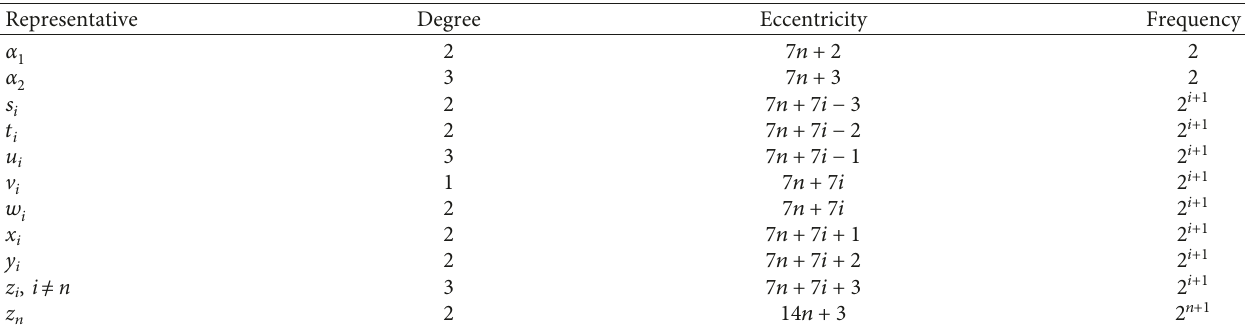
n with degree, eccentricities, and their 1 ( )